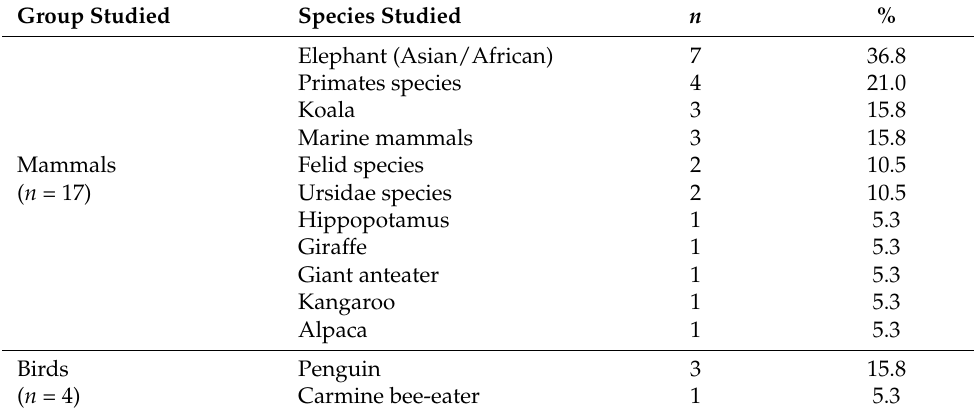
Table 2. Number and percentage of publications by group and studied species. Publications can have more than one studied species.